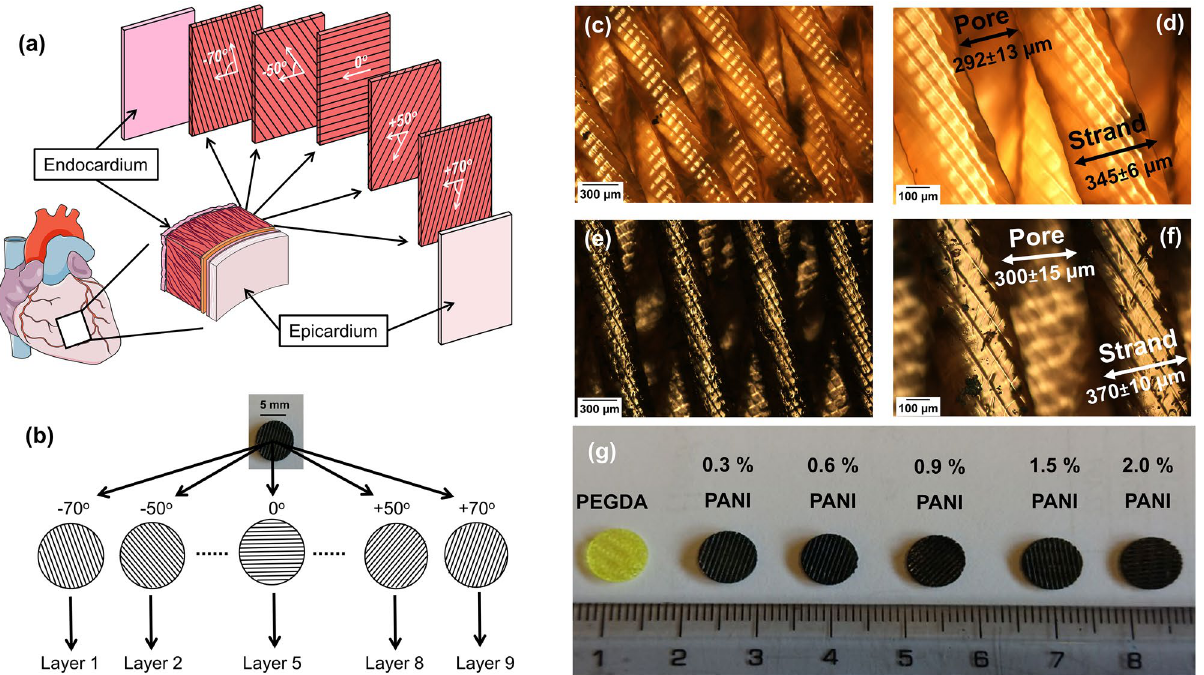
Figure 3. Structure and morphology of the printed scaffolds. ( a ) In the myocardium the myofibers are oriented at different angles in a hierarchical manner. ( b ) Different layers aligned along these angles were stacked on top of each other to obtain a 3D scaffold mimicking this structure. ( c ) Non-conductive PEGDA scaffold at 5X and ( d ) at 10X, ( e ) conductive scaffold (0.3% PANI) at 5X and ( f ) at 10X. ( g ) Scaffolds with different concentrations of PANI. Figure 3A was made using Servier Medical Art under the CC-BY 3.0